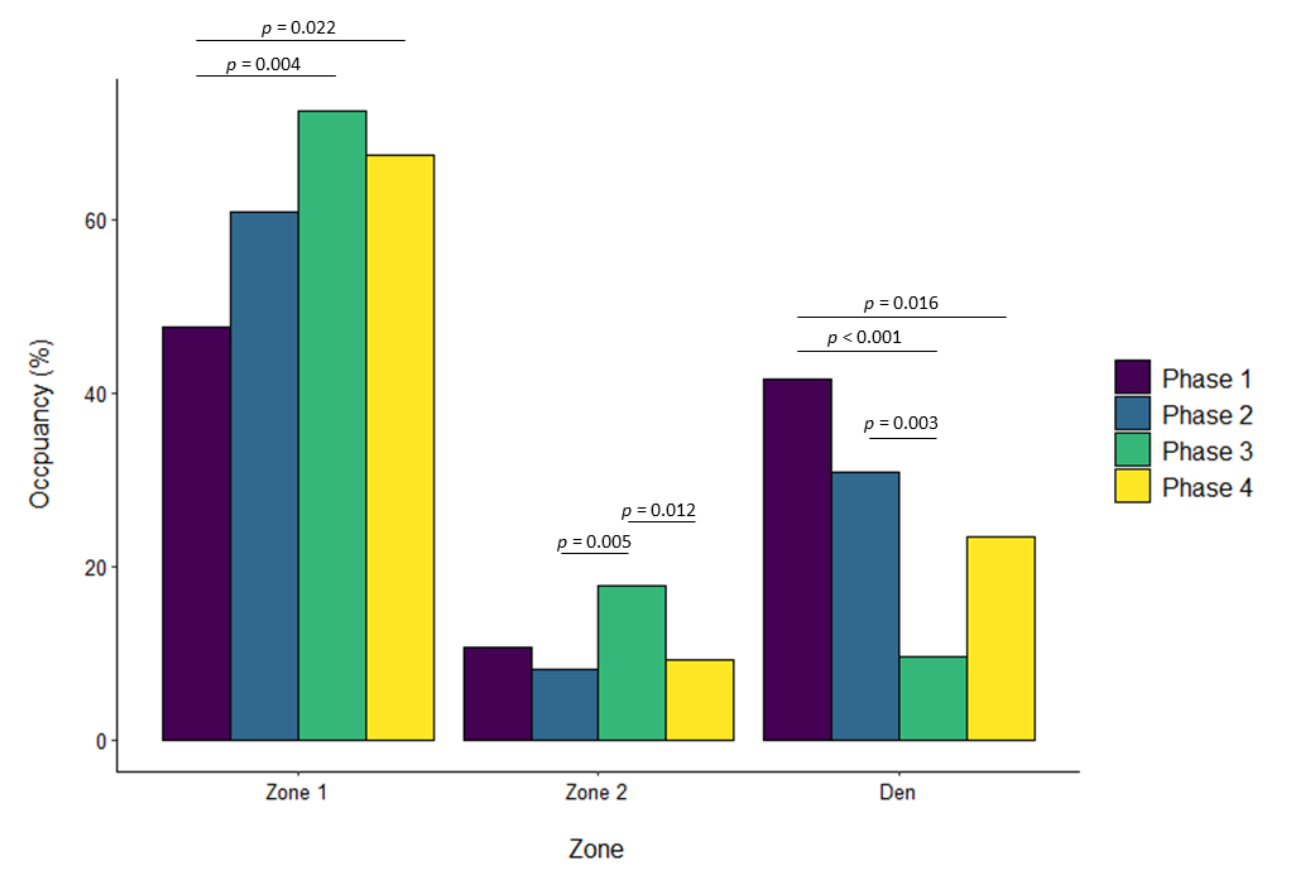
Figure 9. Percent occupancy of each zone by phase for the polar bear. Means and standard deviations for fecal glucocorticoid levels by phase for each species are presented in Table 5. Pairwise comparisons of fecal glucocorticoid levels between phases and associations with temperature and day of the week for the polar bear are presented in Table 8 and Figure 10. Glucocorticoid levels in Phase 3 neared being significantly lower than those observed in Phase 1 and were significantly lower than those observed in Phase 4. Glucocorticoid levels were not significantly different for any other phase comparisons. Fecal glucocorticoid levels also did not vary significantly by temperature or weekday versus weekend day. Table 8. Pairwise comparisons of glucocorticoids by phase as well as associations with temperature and day of the week (weekday vs. weekend) for the polar bear.